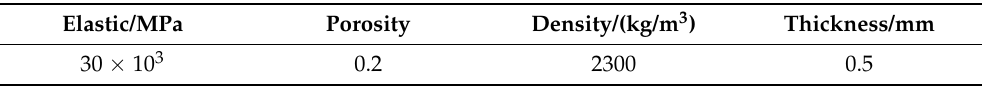
Table 4. Mechanical parameters of the panel.